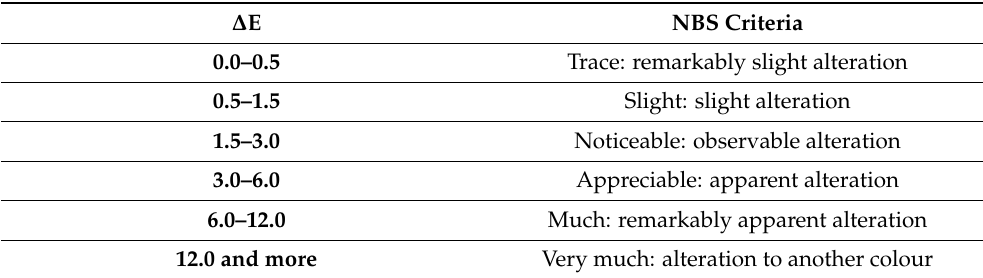
Table 1. National Bureau of Standards (NBS) criteria for the assessment of colour differences ∆